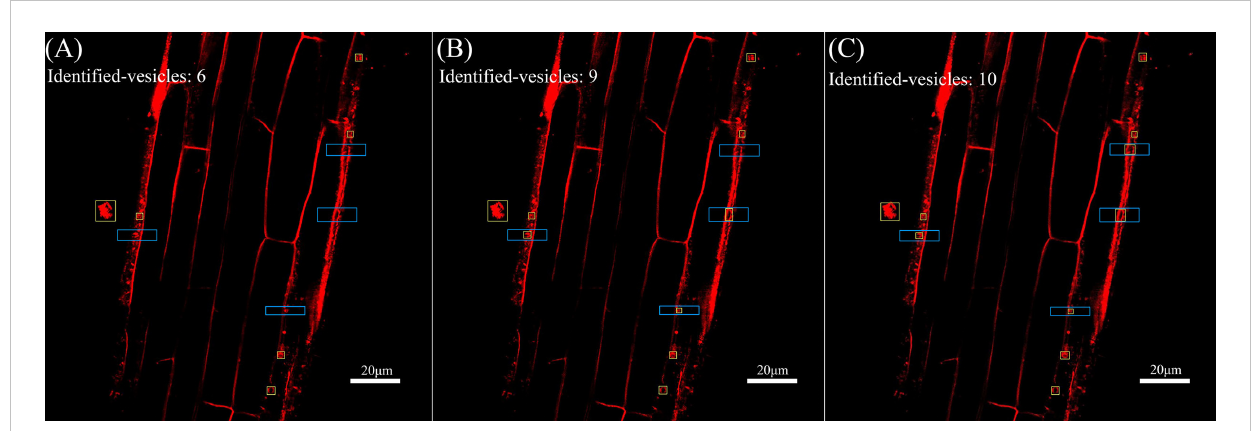
FIGURE 5 Comparison of recognition of endocytic vesicles in laser confocal images of Solanum nigrum root cells. (A) Recognition of endocytic vesicles in original image(pixel: 1024×1024). (B) Recognition of endocytic vesicles in SRGAN single-reconstruction image(pixel: 4096×4096). (C) Recognition of endocytic vesicles in SRResNet single-reconstruction image(pixel: